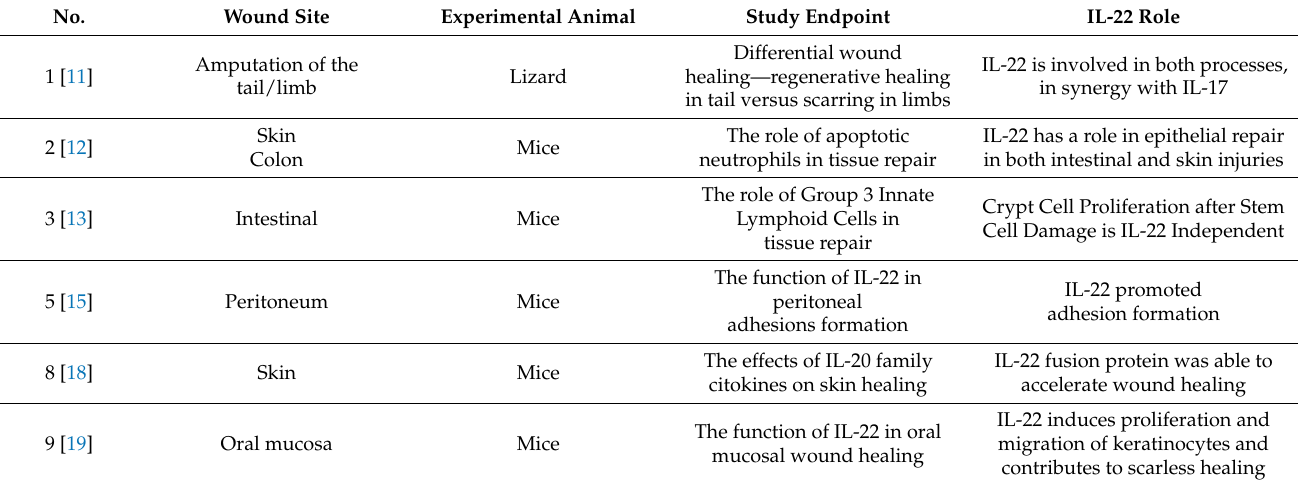
Table 3. Experimental studies included in the systematic